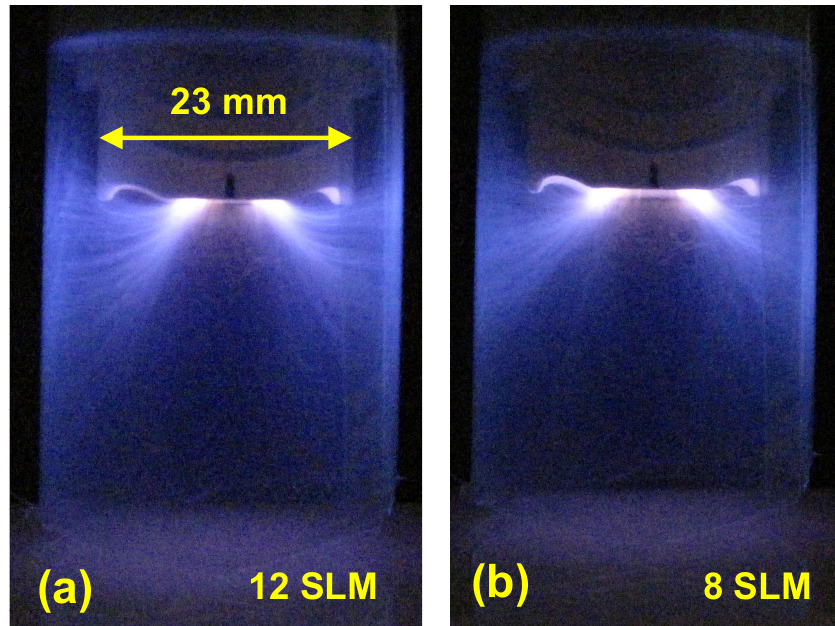
Figure 12. The PDD inside the 30 mm-long liner extension for nitrogen flow of ( a ) 12 SLM and ( b ) 8 SLM.